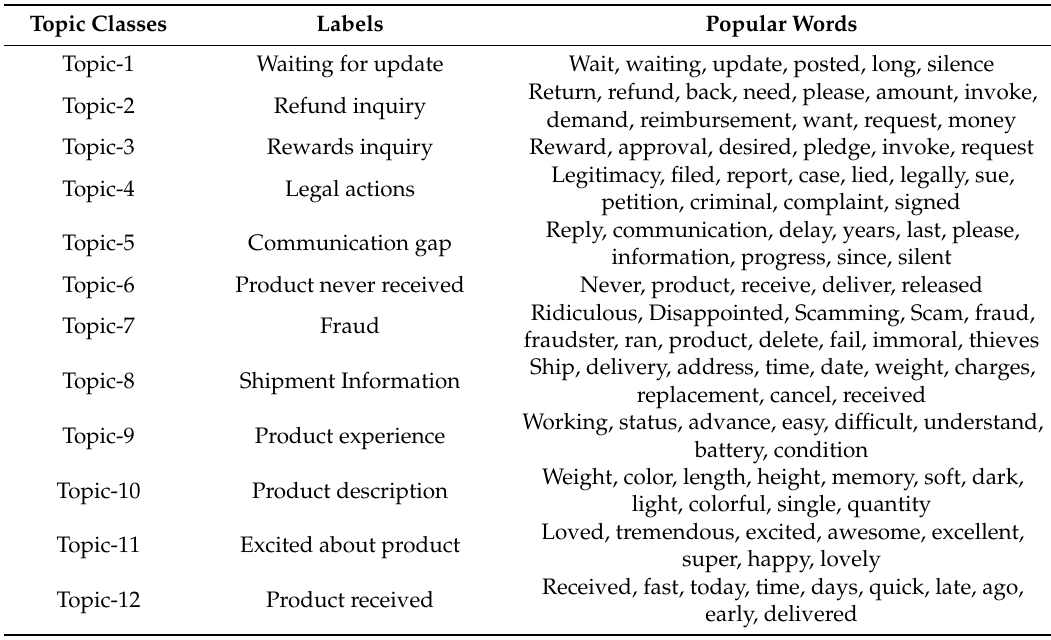
Table 2. Topic classes identified using LDA